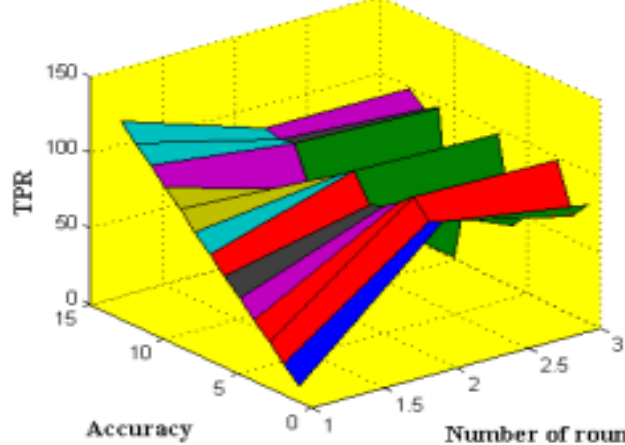
Figure 9. Accuracy vs. number of rounds.